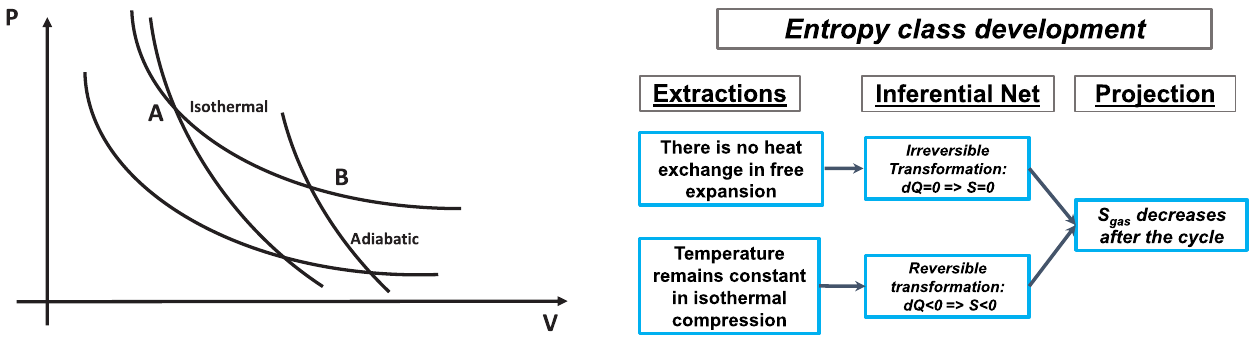
FIG. 5. Students ’ sketch during segment 2. FIG. 6. Diagram of the projection development during segment 2. In blue, F ’ s contributions.